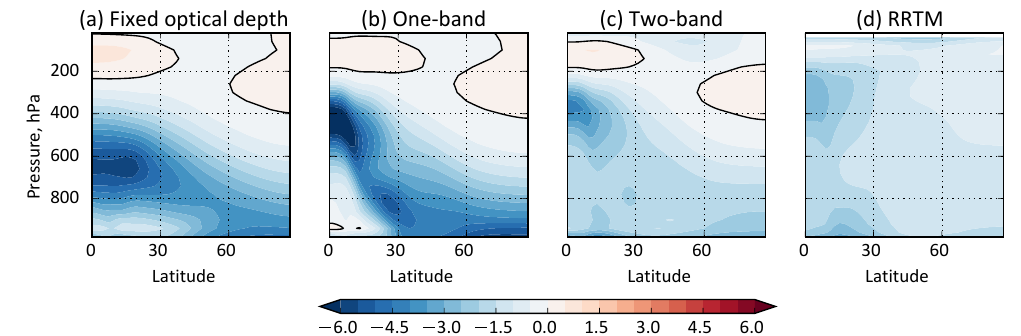
Figure 2. Long-wave heating rates (Kday − 1 ) for some of the radiation schemes available in Isca, for the given temperature and specific humidity fields shown in Fig. 3. The leftmost panel shows results with a grey scheme with a fixed optical depth, a function only of pressure and latitude, as in Frierson et al. (2006). The one-band scheme is also grey, but has an optical depth that is a function of water vapour and CO 2 . The two-band scheme has two infrared bands, and the RRTM scheme is a full, multiband scheme, and both have water vapour and CO 2 dependence.